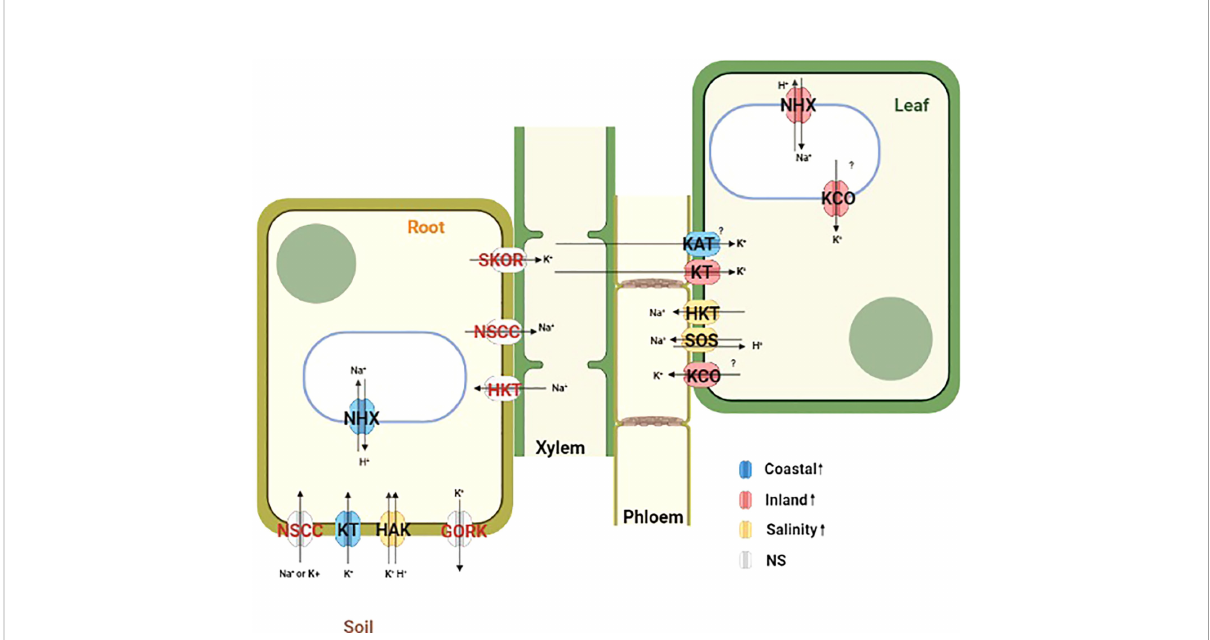
FIGURE 6 Schematic diagram representing the localization and function of a priori ion transporters and vacuolar ATPases which plays important role in maintaining ion homeostasis during salinity stress. Differentially expressed genes from this study are mapped in this diagram based on the functional annotation of Panicum hallii gene models. Ion transporters are color coded by their expression patterns (Blue=Coastal genotype speci fi c overexpression, Red=Inland genotype speci fi c overexpression, Yellow=Overexpression during salinity treatment irrespective of genotype and Gray=No signi fi cant detectable